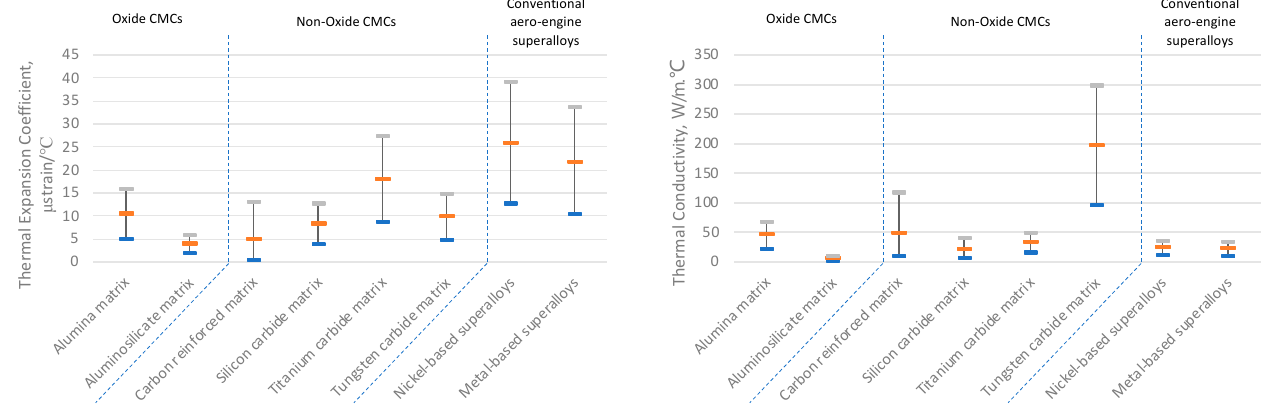
Figure 12. ( Left ) Thermal expansion coefficient and ( right ) thermal conductivity of CMCs and comparison with superalloys.